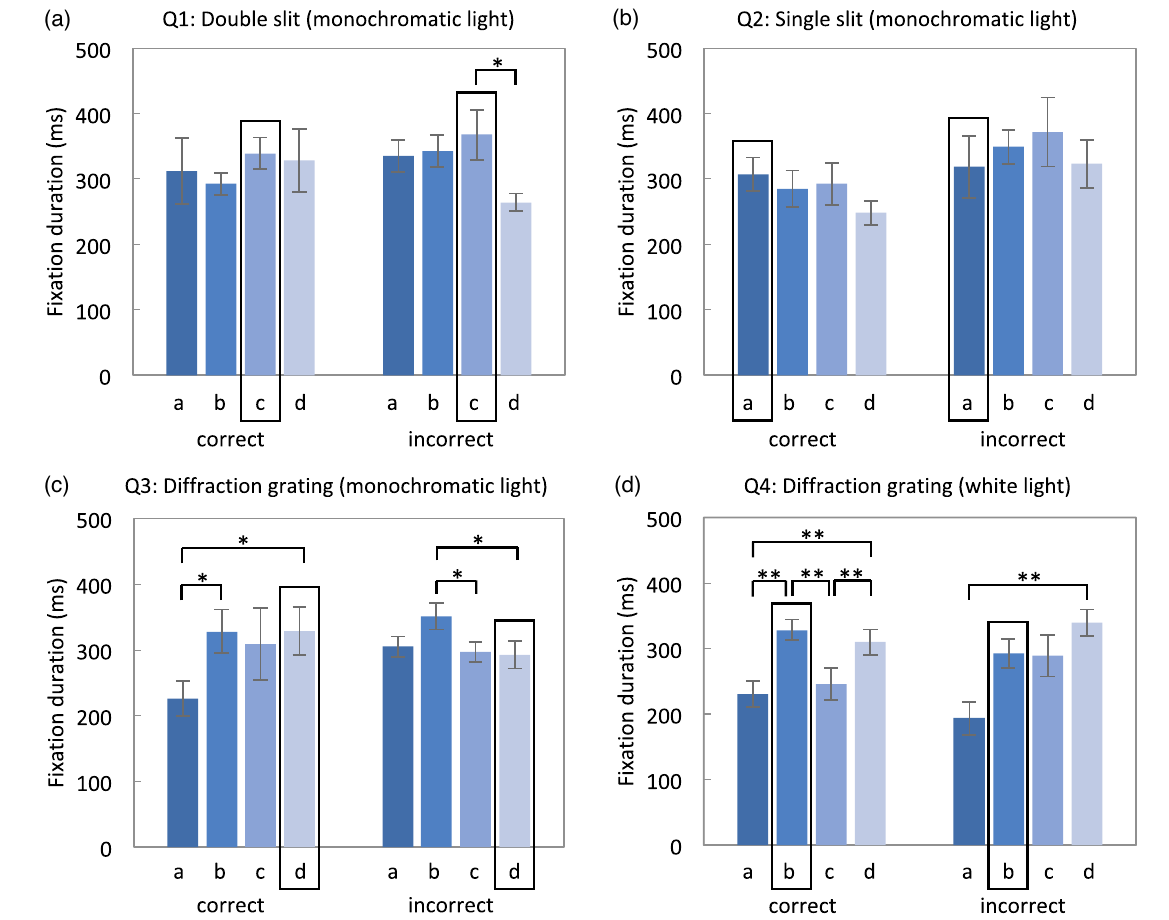
FIG. 3. Fixation durations for multiple-choice answers ( a , b , c , and d ) for each question (Q1, Q2, Q3, and Q4), evaluated separately for students who correctly and incorrectly answered the question. Rectangles show correct answers. One or two asterisks indicate significantly different pairwise comparisons at levels of p < 0 . 05 or p < 0 . 01 , respectively.